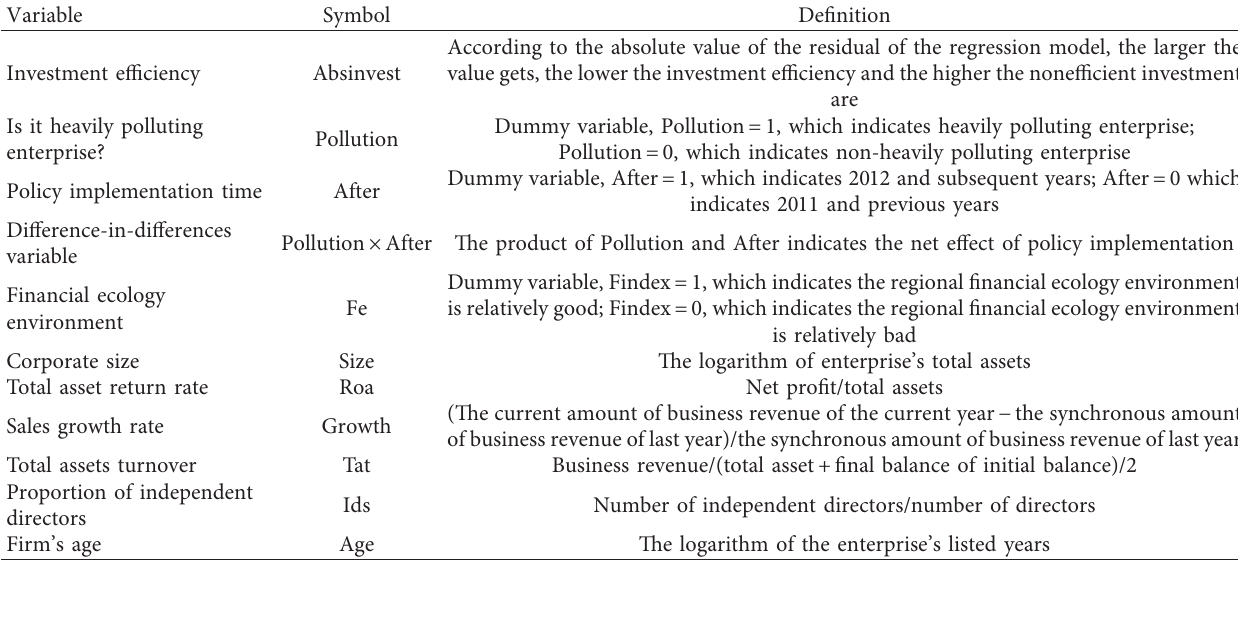
Table 1: Main definitions of